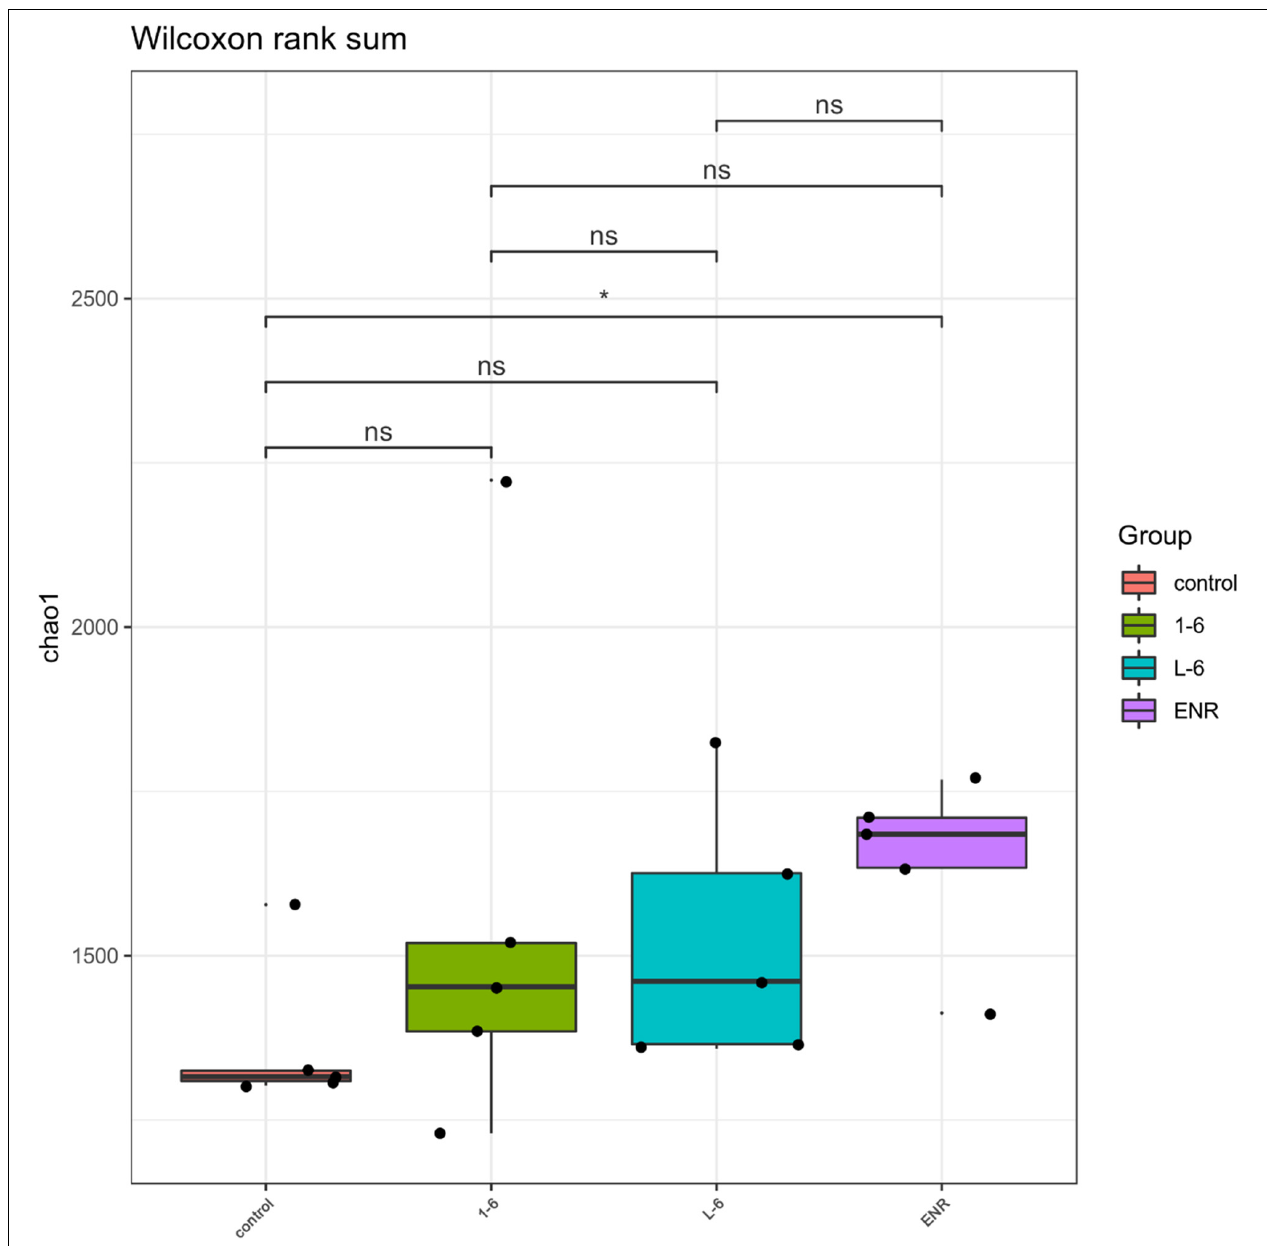
FIGURE 11 | Analysis of intestinal microflora α diversity of Sebastes schlegelii . The t -test was used to evaluate significant differences between controls and treatment groups. * p <